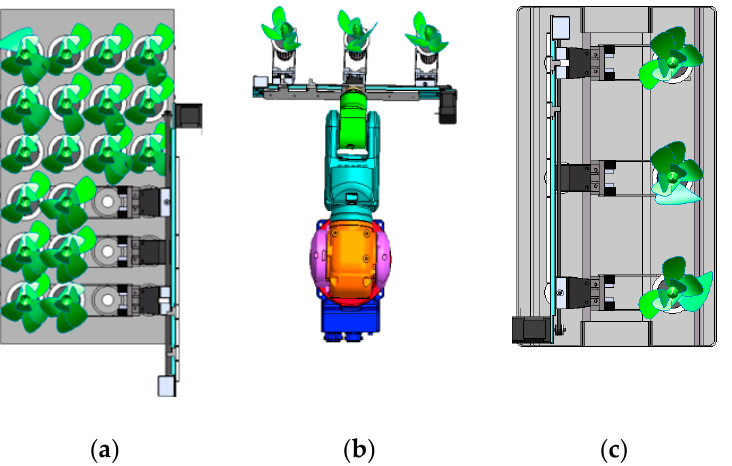
Figure 16. Three-claw transplanting actuator work plan. ( a ) Taking seedlings; ( b ) detection; ( c ) transplanting.